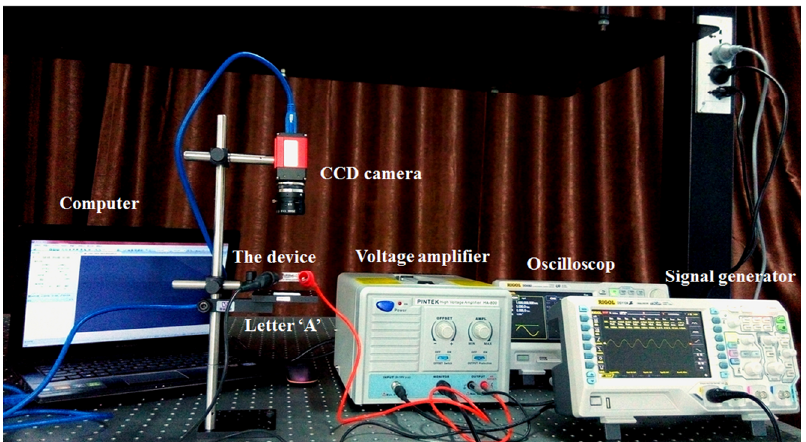
Figure 3. Optical setup of the